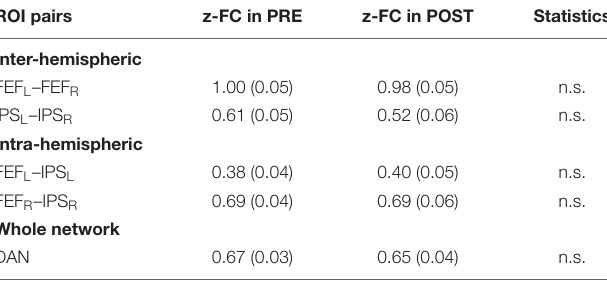
TABLE 1 | Intra- and interhemispheric ROI-to-ROI functional connectivity in the DAN before (PRE) and after (POST) task performance. ROI pairs z-FC in PRE z-FC in POST